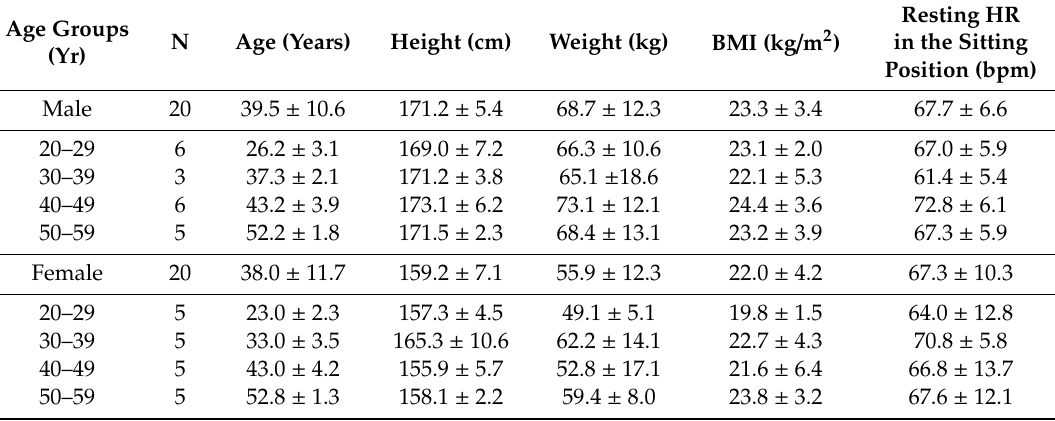
Table 3. Physical characteristics of the